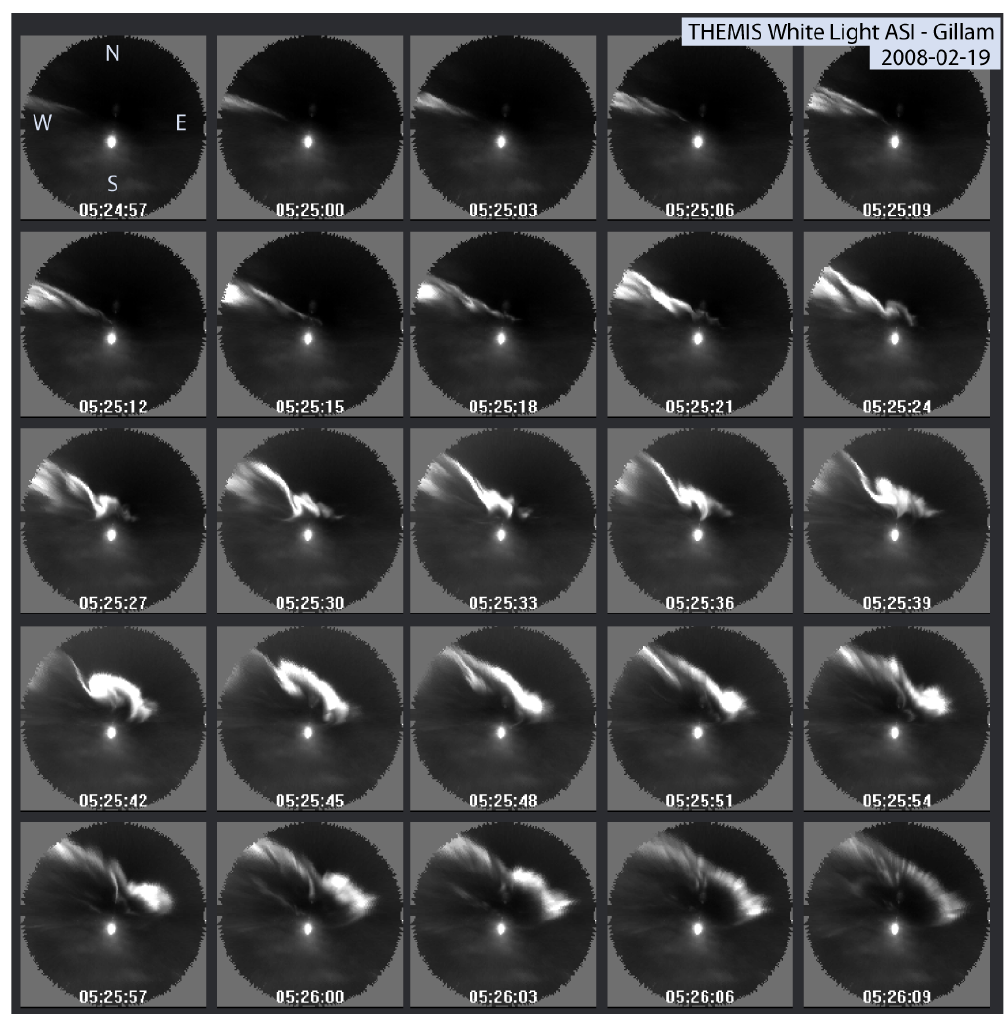
Fig. 3a. Extended sequence of ASI images showing the development of the (a) first and (b) second auroral spiral, recorded at GILL and SNKQ, respectively. Images are three seconds apart. The bright spot in each ASI image is the Moon.